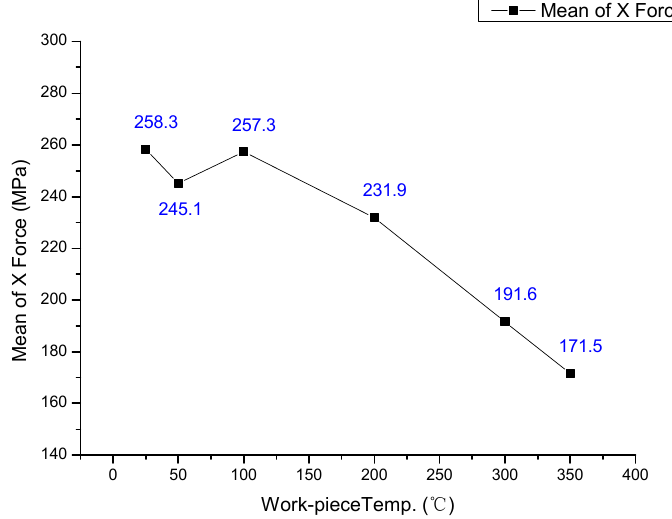
Figure 13. Mean reaction force at different workpiece temperatures.